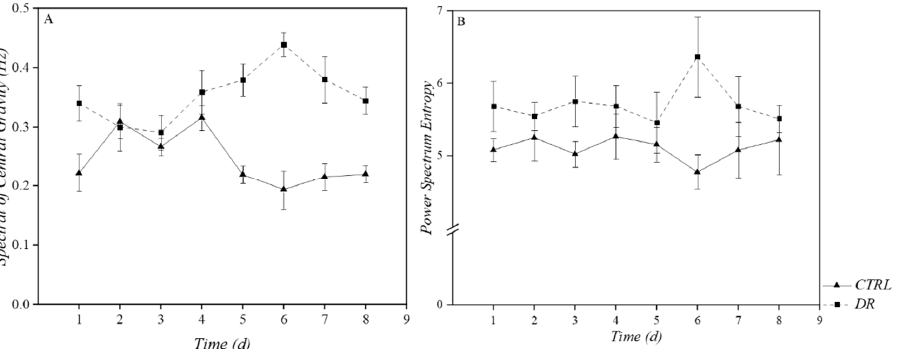
Figure 6. The change of time-domain parameter during the experiment (Day 1–Day 8). ( A ) is the change of Spectral of Central Gravity; ( B ) is the change of power spectrum entropy; i.e., control (CTRL), drought (DR).